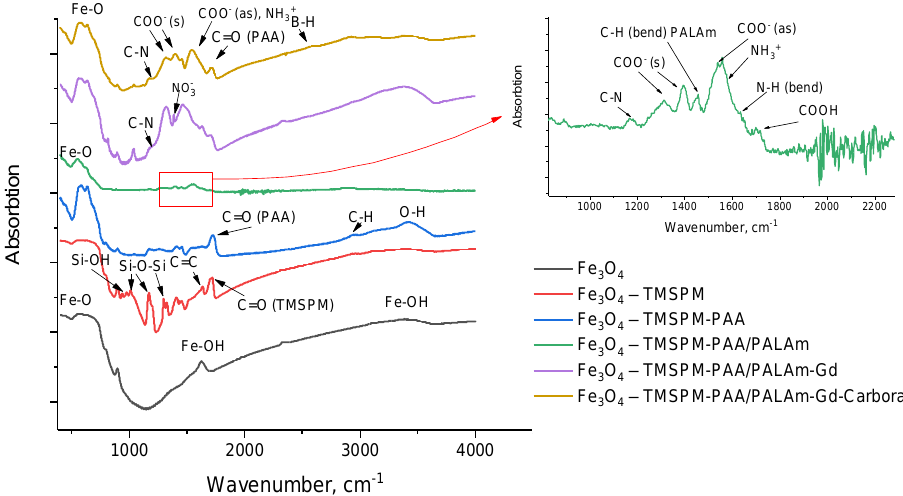
Figure 1. FTIR spectra of Fe 3 O 4 , Fe 3 O 4 -TMSPM, Fe 3 O 4 -TMSPM-PAA, Fe 3 O 4 -TMSPM-PAA/PALAm, Fe 3 O 4 -TMSPM-PAA/PALAm-Gd, Fe 3 O 4 -TMSPM-PAA/PALAm-Gd-Carborane.